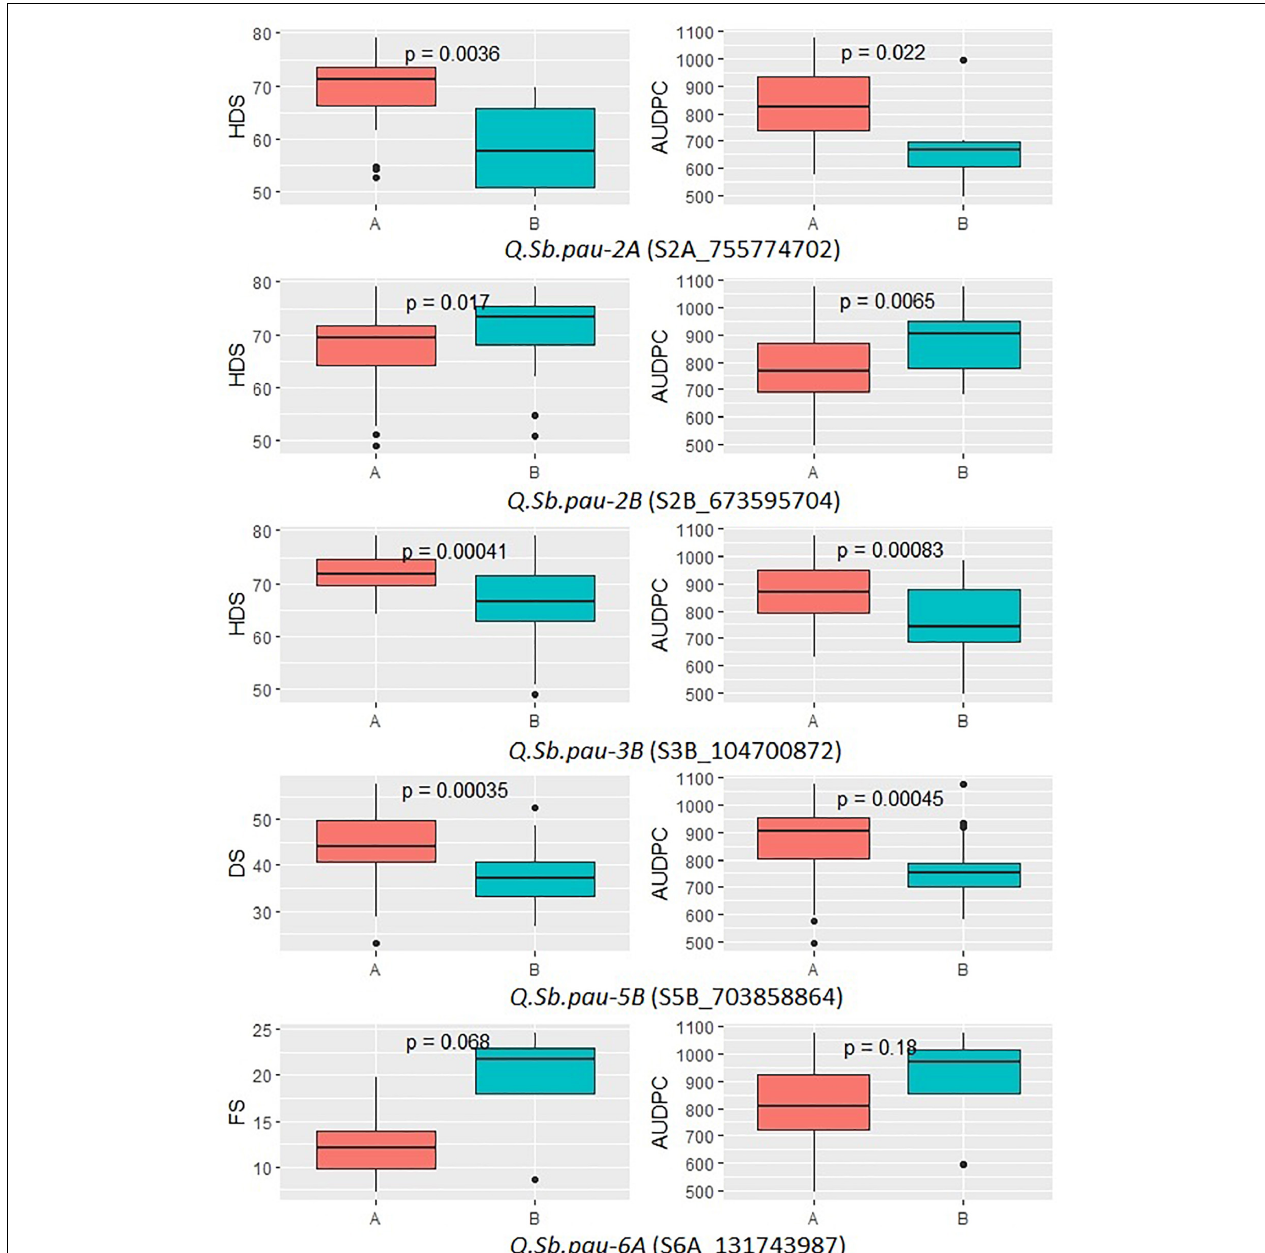
FIGURE 4 | Boxplots showing the effect of phenotypic variation between the two alleles of the SNP markers linked to QTLs for disease score of DSBILs. Kruskal–Wallis test was used to determine the significant differences between the mean values of two alleles.